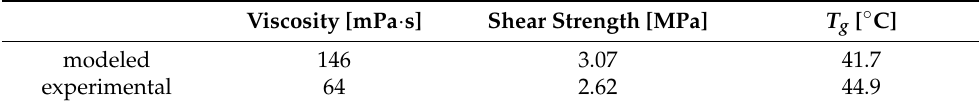
Table 10. A comparison of actual and modeled properties of an optimized